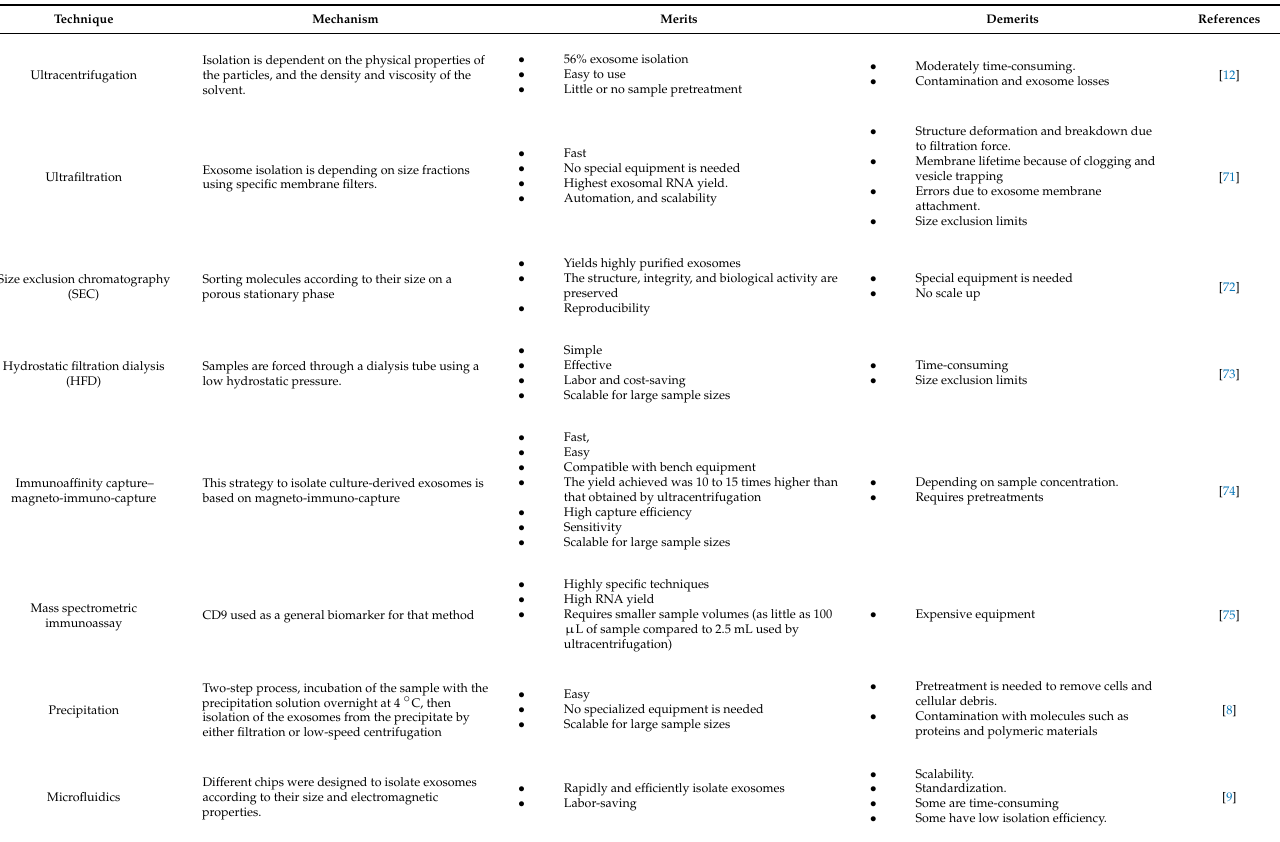
Table 1. Isolation techniques for exosomes.